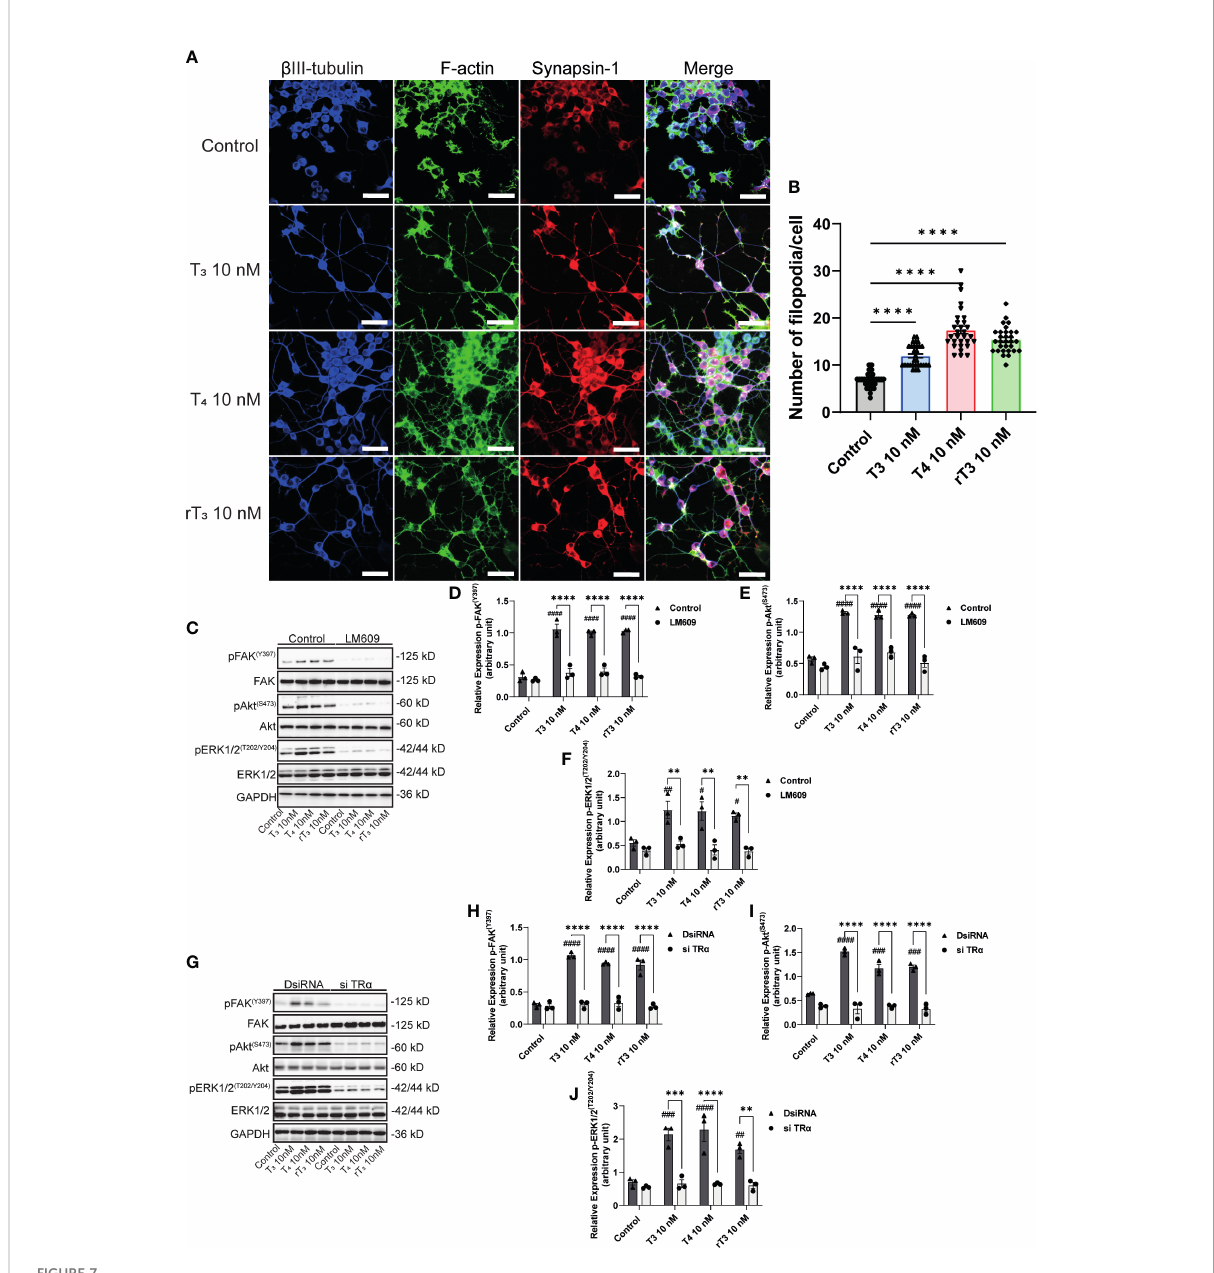
FIGURE 7 Effect of TH on F-actin formation and phosphorylation of FAK, Akt, and ERK1/2. A. Representative photomicrographs showing the effects of TH on the fi lopodia formation in Neuro-2A cells. Differentiation of Neuro-2A cells was induced by serum starvation for one to three days, followed by immunostaining with b -tubulin III (blue), F-actin (green), and synapsin-1 (red). (B) Quantitative analysis of fi lopodia formation in Neuro-2A cells after TH treatment. (C) Representative images of blots for pFAK, FAK, pAkt, Akt, pERK1/2, ERK1/2, and GAPDH levels following TH treatment and co-exposure to 2 µg/mL LM609. Quantitative analysis of the effect of TH on protein expression levels of FAK (Y397) (D) , Akt (S473) (E) , and ERK1/2 (T202/Y204) (F) . (G) Representative images of blots for pFAK, FAK, pAkt, Akt, pERK1/2, ERK1/2, and GAPDH levels in response to TH treatment after deletion of TR a . Quantitative analysis of the effect of TH on FAK (Y397) (H) , Akt (S473) (I) , and ERK1/2 (T202/Y204) protein expression levels (J) . ImageJ Fiji software (NIH) was used to quantify the blots. Data are shown as the mean±SEM and representative from at least three independent experiments. #### p <0.0001, ### p <0.001, ## p <0.01 and # p <0.05 indicate statistical signi fi cance according to two- way ANOVA continued with post hoc Turkey test compared to control. **** p < 0.0001, *** p < 0.001 and ** p < 0.01 indicate statistical signi fi cance according to two-way or one-way ANOVA continued with post hoc Turkey test. See Supplementary Table